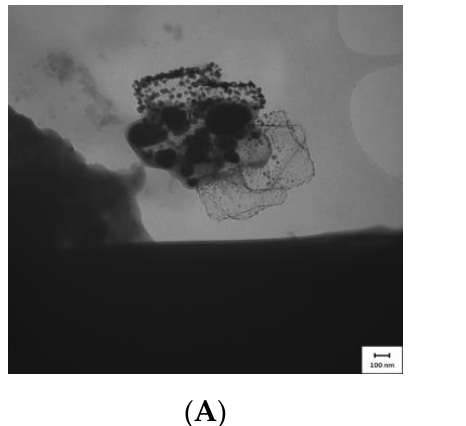
discussed earlier in the X-ray results confirmed the presence of ZnO and AlPO 4 , which